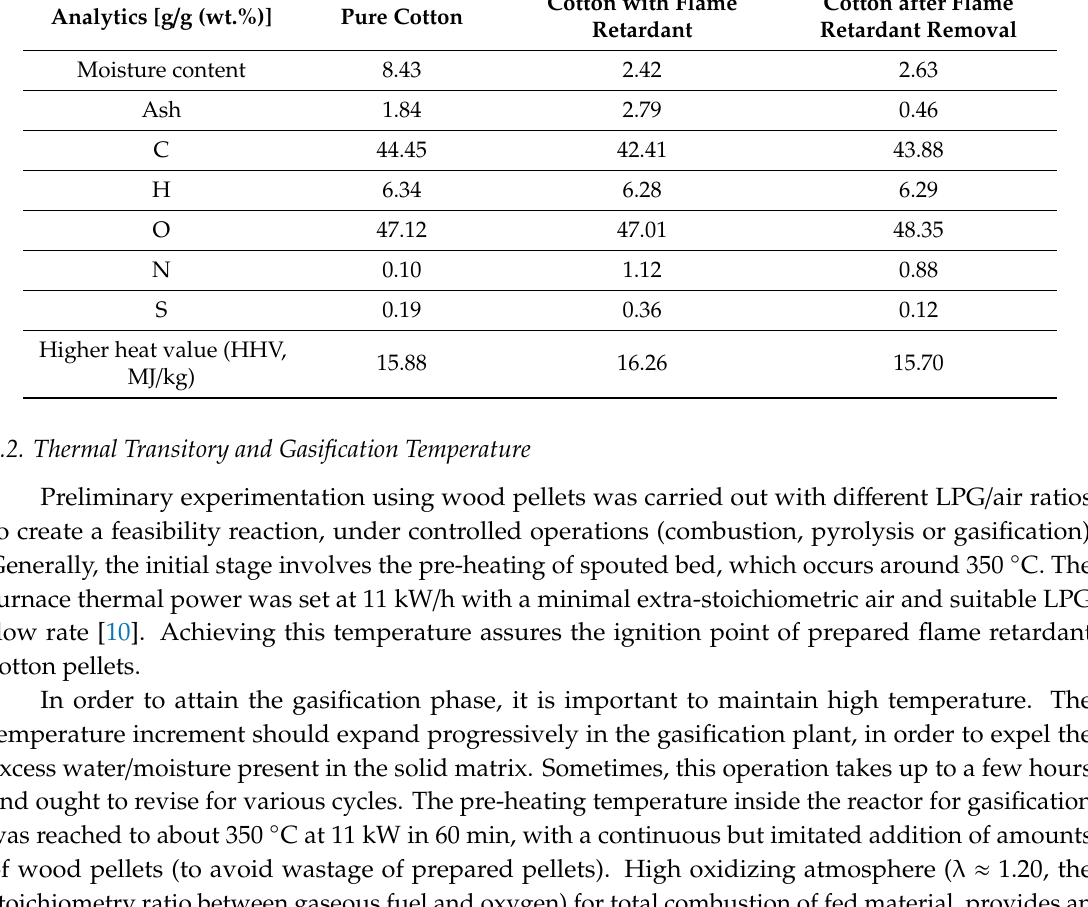
Table 1. Proximate analysis and calorific values of prepared pellets for gasification. Analytics [g / g (wt.%)] Pure Cotton Moisture